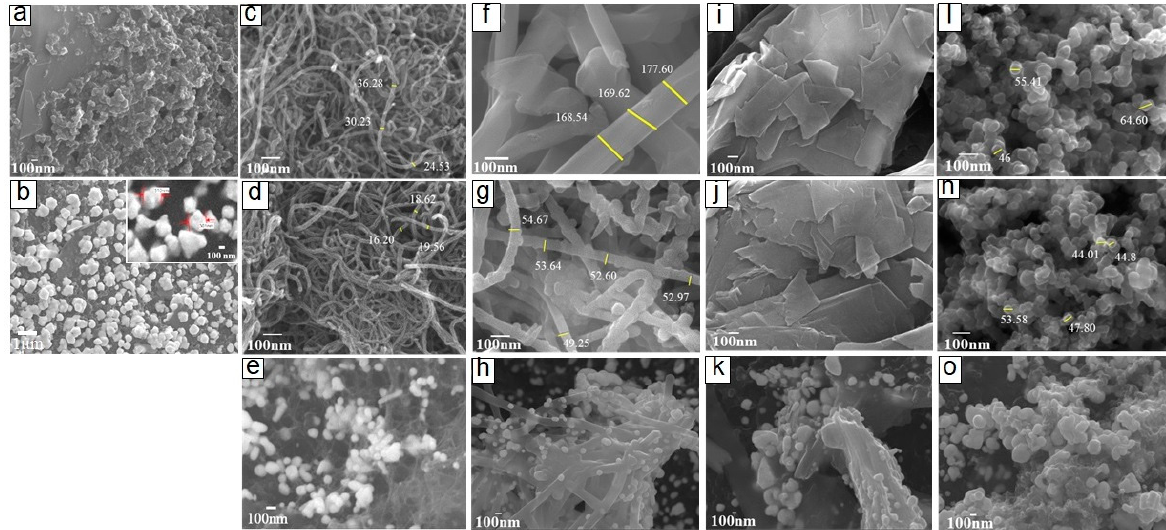
Figure 1. SEM of ( a ) bare SPE, ( b ) 50 cycles AuNPs, ( c ) pristine MWCNTs, ( d ) oxidized MWCNTs, ( e ) 50AuNPs@MWCNTs, ( f ) pristine VGCFs, ( g ) oxidized VGCFs, ( h ) 50AuNPs@VGCFs, ( i ) pristine KS4, ( j ) oxidized KS4, ( k ) 50AuNPs@KS4, ( l ) pristine SP, ( n ) oxidized SP, and ( o ) 50AuNPs@SP.